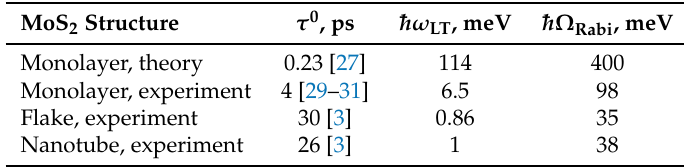
Figure 3. Color plot of the PL’s spectral dependence on the detection angle calculated for the NTs without inhomogeneous broadening of the exciton resonance and different values of Rabi splitting, 2 meV, 20 meV, and 200 meV ( a – c ). The dotted lines show the dispersion of the eigenmodes with the angular quantum numbers m = 19, 20, and 21. The black solid line indicates the energy of the exciton. UPs and LPs denote upper and lower polariton modes, respectively. Table 1. Experimental and theoretical MoS 2 exciton radiative lifetimes for different structures: monolayer, flake, and nanotube. Respective longitudinal-transverse splitting and Rabi splitting are calculated as described in the